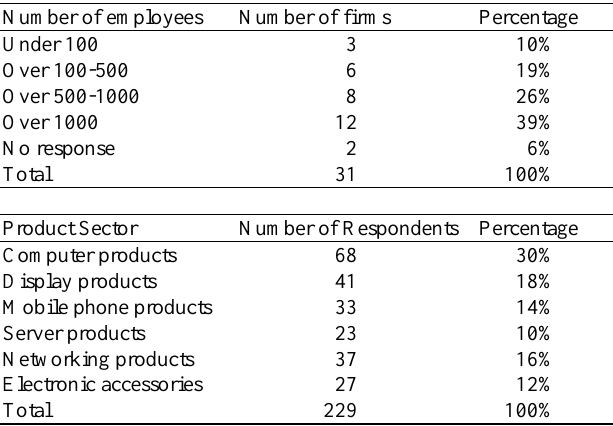
Table 1: Sample characteristics